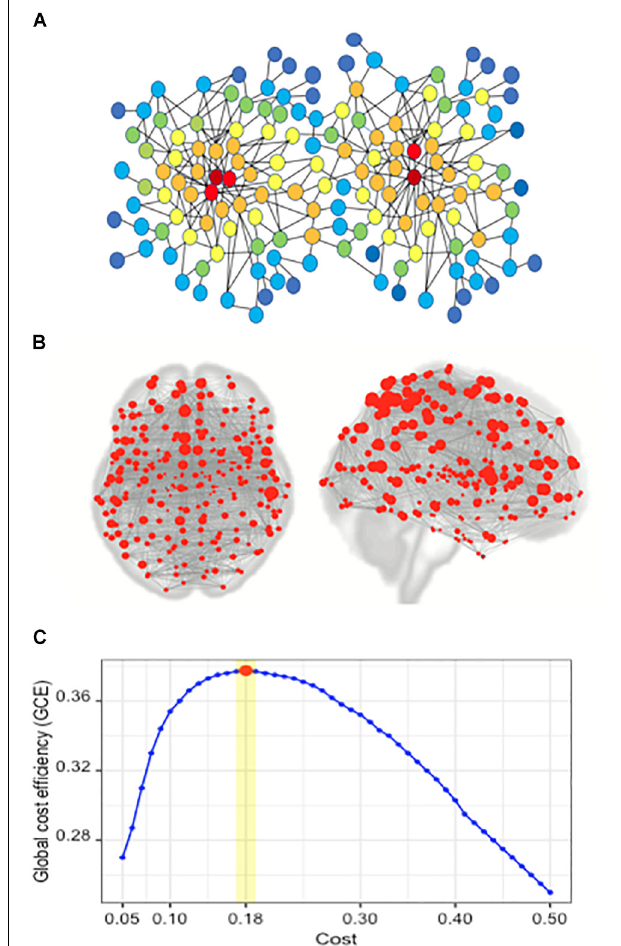
FIGURE 1 | Network and the concept of degree centrality; the brain network of the Brainnetome atlas’ ROIs; finding the optimal cost. (A) In the illustrated network, the red nodes have the highest degree centrality, and the color spectrum from red to blue represents the gradual reduction of degree centrality. (B) Red circles represent the nodes in a brain network, composed of 246 nodes. In this network, each node is one of the 246 ROIs of the Brainnetome Atlas. (C) Plot of global cost efficiency vs. Cost averaged across all subjects in young HC, senior and MCI